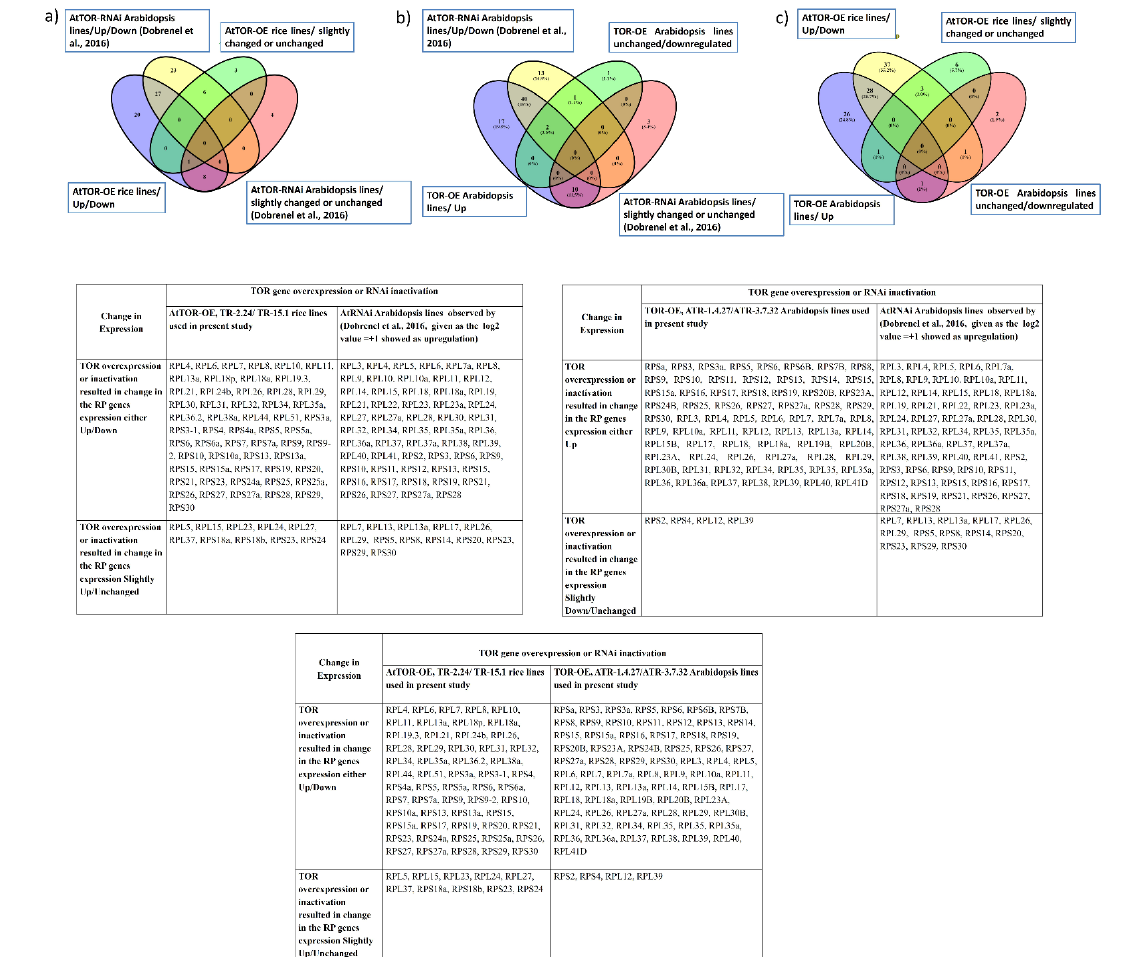
Figure 4. Comparison of the overlapping expression patterns of RPL and RPS genes in TOR -OE lines of rice and Arabidopsis with the AtTOR -RNAi Arabidopsis lines. The RP genes exhibiting a transcript level of ≥ 1-fold on log 2 scale were considered as significantly upregulated and the transcript level below 1-fold was considered downregulated or unchanged in expression. Venn diagrams are used to show the overlaps between the RP gene expression ( a ) in the TOR -RNAi lines of Arabidopsis (Dobrenel et al., 2016 [19]) and TOR -OE lines of rice, TR-2.24 and TR-15.1, ( b ) in the TOR -RNAi lines of Arabidopsis and TOR -OE Arabidopsis lines, ATR-1.4.27 and ATR-3.7.32, and ( c ) in the TOR -OE lines of rice, TR-2.24 and TR-15.1, and ATR-1.4.27 and ATR-3.7.32 Arabidopsis transgenic lines.